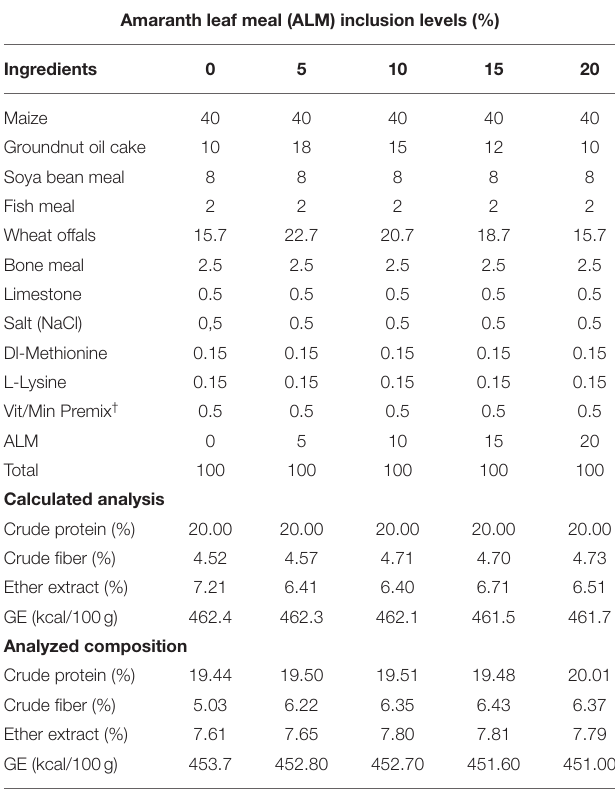
TABLE 2 | Ingredients and calculated analysis of experimental